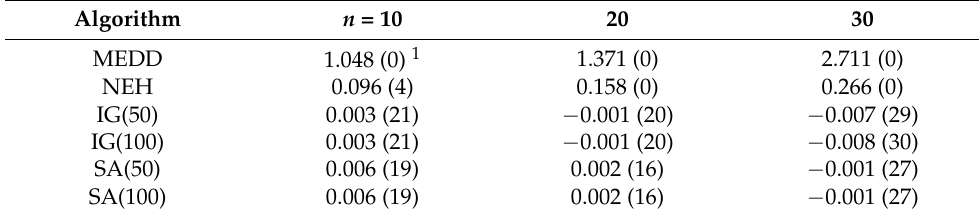
Table 3. Performance of the heuristic algorithms (vs.